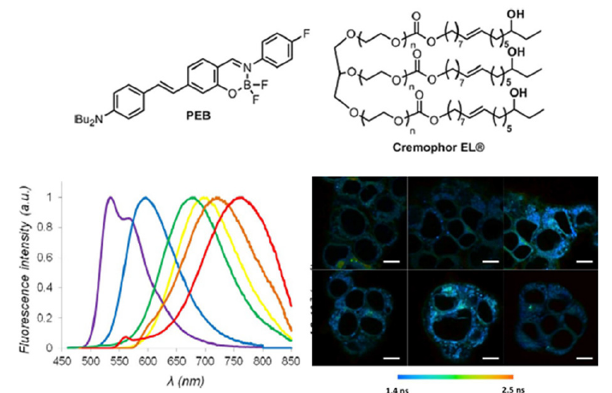
Figure 4. Cellular imaging using fluorescent boranils probes [33]. Emission spectra on the bottom left curves: (purple) cyclohexane, (blue) toluene, (green) THF, (yellow) DCM, (orange) acetone, (red) DMSO. Adapted from Reference [33]. Copyright 2017 John Wiley and Sons.